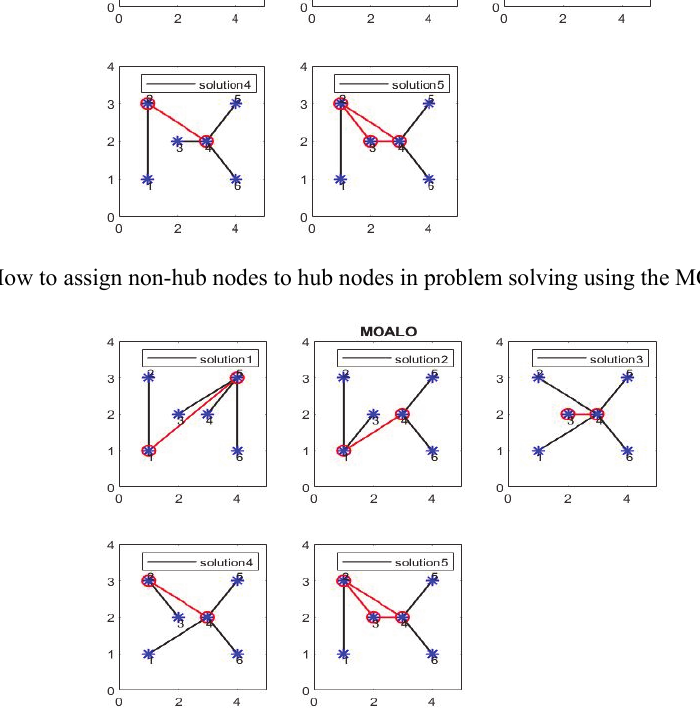
Fig. 11 . How to assign non-hub nodes to hub nodes in problem solving with the MOALO algorithm